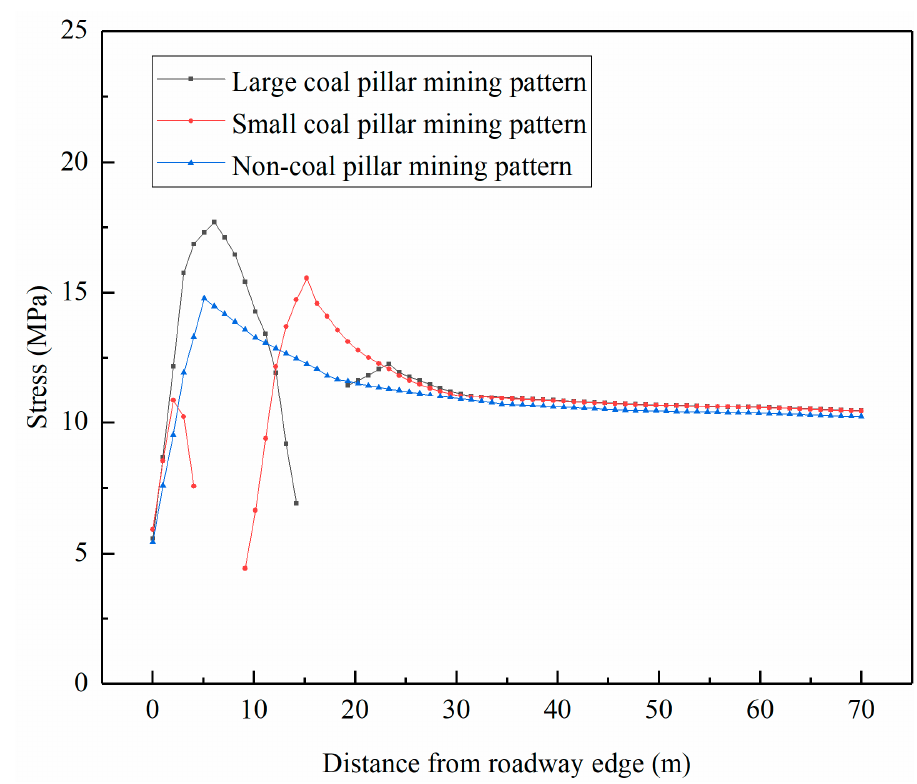
Figure 12. Vertical stress distribution curve at monitoring line 7 in lateral direction of the working face. Table 5. Key parameters of the stress distribution characteristics in the left front of the working face. Monitoring Mining Line Mode